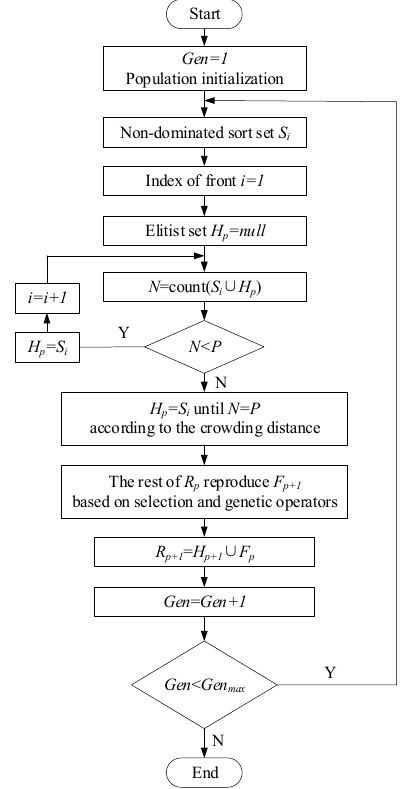
Figure 6. The detailed program flow of NSGA-II.